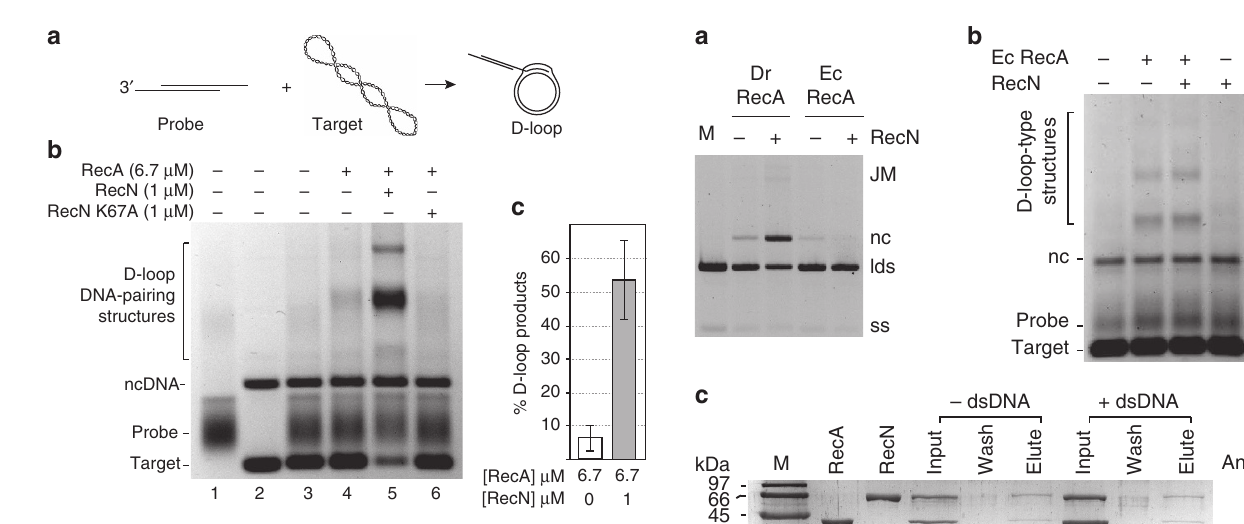
500 nM RecN protein stimulates product formation by RecA protein more than threefold under these conditions (Fig. 1d). stimulatory effect of adding RecN to a RecA-mediated displace- ment loop (D-loop) reaction (Fig. 2). D-loops form when RecA filament promotes synapsis of a 3 0 -overhang on the probing DNA sequence with a complementary region of a homologous target duplex DNA molecule (Fig. 2a). This type of reaction is thought to mimic the initial pairing step of recombinational DSB repair 3 .